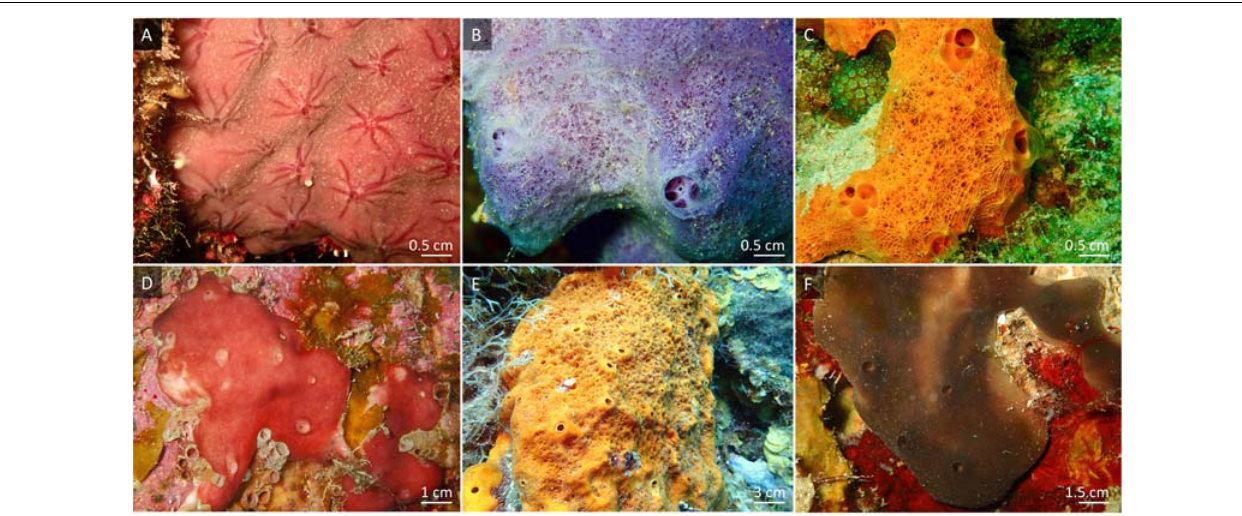
FIGURE 1 | In situ views of the sponge species used in this experiment. (A) Halisarca caerulea, (B) Haliclona vansoesti , (C) Scopalina ruetzleri , (D) Chondrilla caribensis , (E) Ectyoplasia ferox and (F) Plakortis angulospiculatus . (A–C) Low microbial abundance (LMA) sponge species. (D–F) High microbial abundance (HMA) sponge